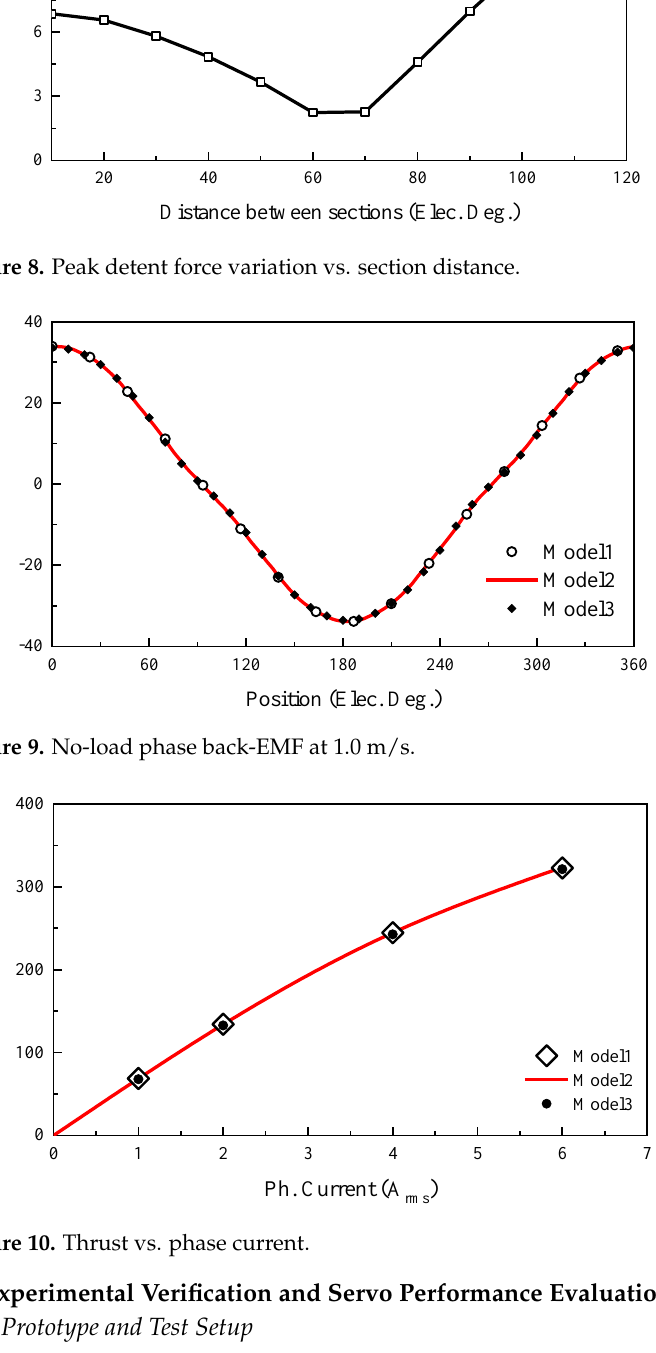
Figure 10. Thrust vs. phase current.